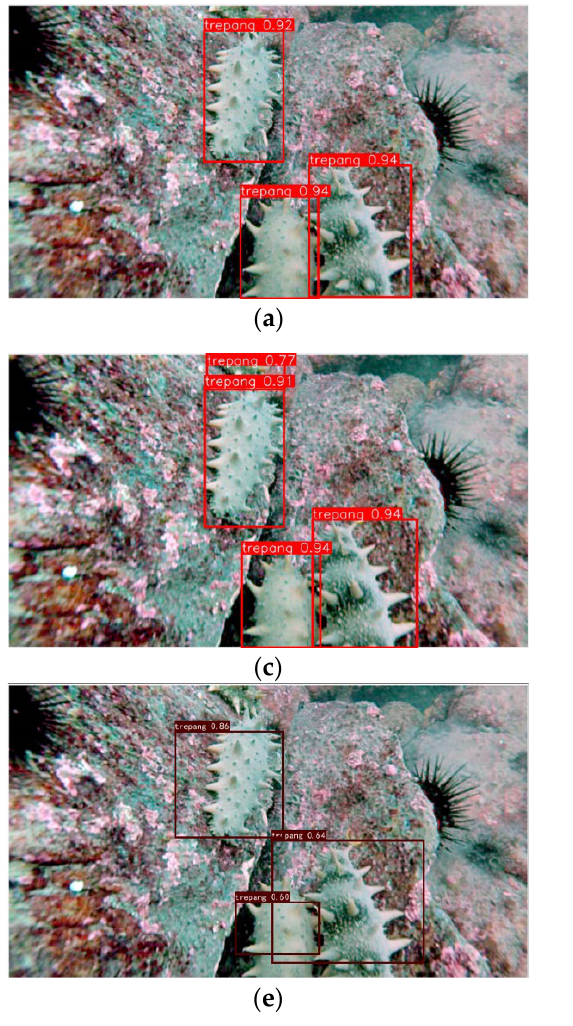
( f ) Figure 10. Curve of parameters with number of epochs: image ( a ) is the precision change curve; image ( b ) is the recall change curve; image ( c ) and image ( d ) are mAP curves; image ( e ) is the loss value change curve; and image ( f ) is the Confusion matrix. 5. Results and Analysis In order to verify the performance of the target recognition algorithm of underwater sea cucumber, the single image library and the mixed image library were trained and tested using the improved YOLOv5s, YOLOv5s, YOLOv4, and Faster-RCNN models. 5.1. Sea Cucumber Identification for the Single Gallery Select a single image library taken in the same video and test it using the YOLO model and the improved model, respectively. There are 845 images in total, with training sets, validation sets, and test sets distributed according to 8:1:1. Figure 10 shows the com- parison of the improved YOLOv5s, YOLOv5s, YOLOv4, and Faster-RCNN test results. Figure 11a,c are the results of YOLOv5s,;Figure 11b,d are the results of improved YOLOv5s; Figure 11e is the YOLOv4 result; and Figure 11f is the Faster-RCNN result. Figure 11a,b comparisons show that improved YOLO can detect when YOLOv5s does not